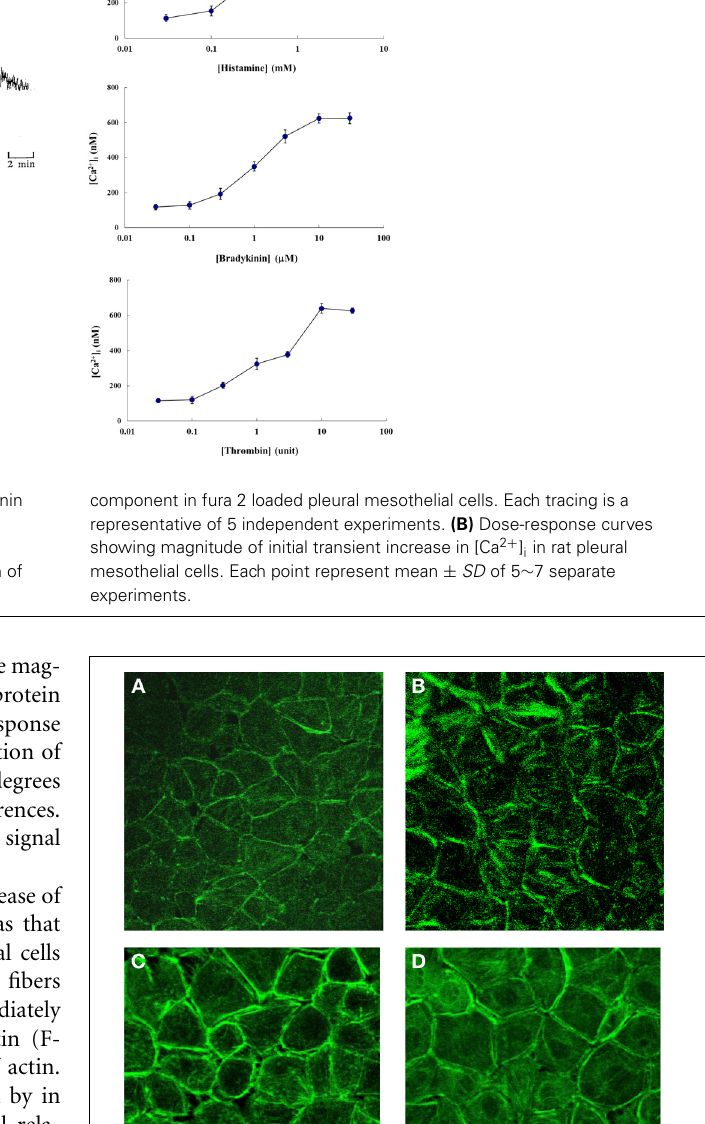
FIGURE 3 | The effects of histamine (1mM), bradykinin (10 µ M), and thrombin (10 U) on F-actin cytoplasmic distribution in rat pleural mesothelial cells. Control (A) , after 5min exposure histamine (B) , bradykinin (C) , and thrombin (D) .